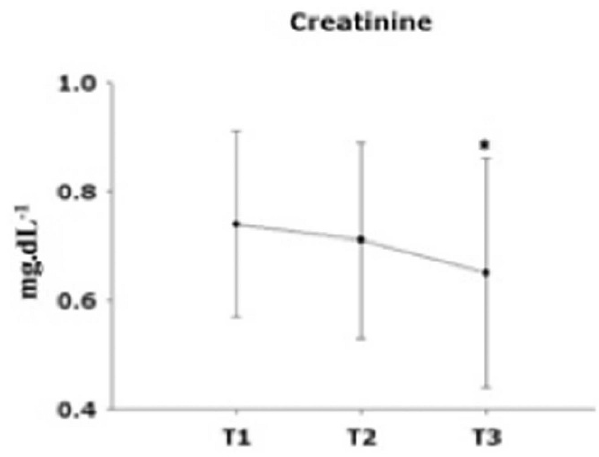
Figure 4 - Creatinine in mg.dL -1 (mean ¡ standard deviation) at baseline (T1), 30 minutes after abdominal insufflation (T2), and 30 minutes after abdominal deflation (T3). * p , 0.05 versus